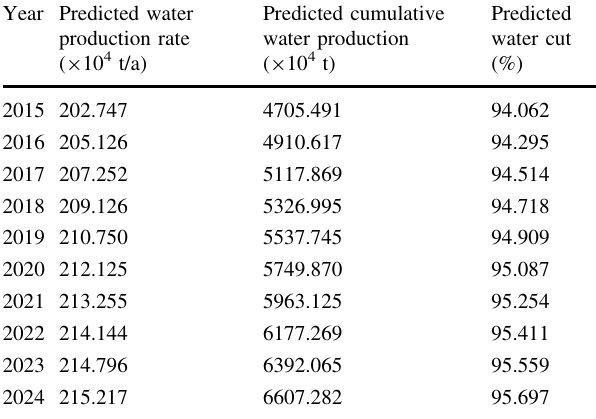
Table 4 Predicted water cut of M oilfield